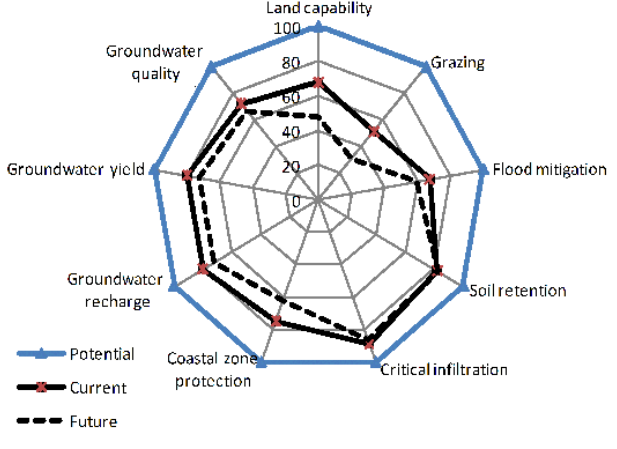
Fig. 2 . Changes (present) and potential changes (future) in ecosystem service supply shown as a percentage of the potential service